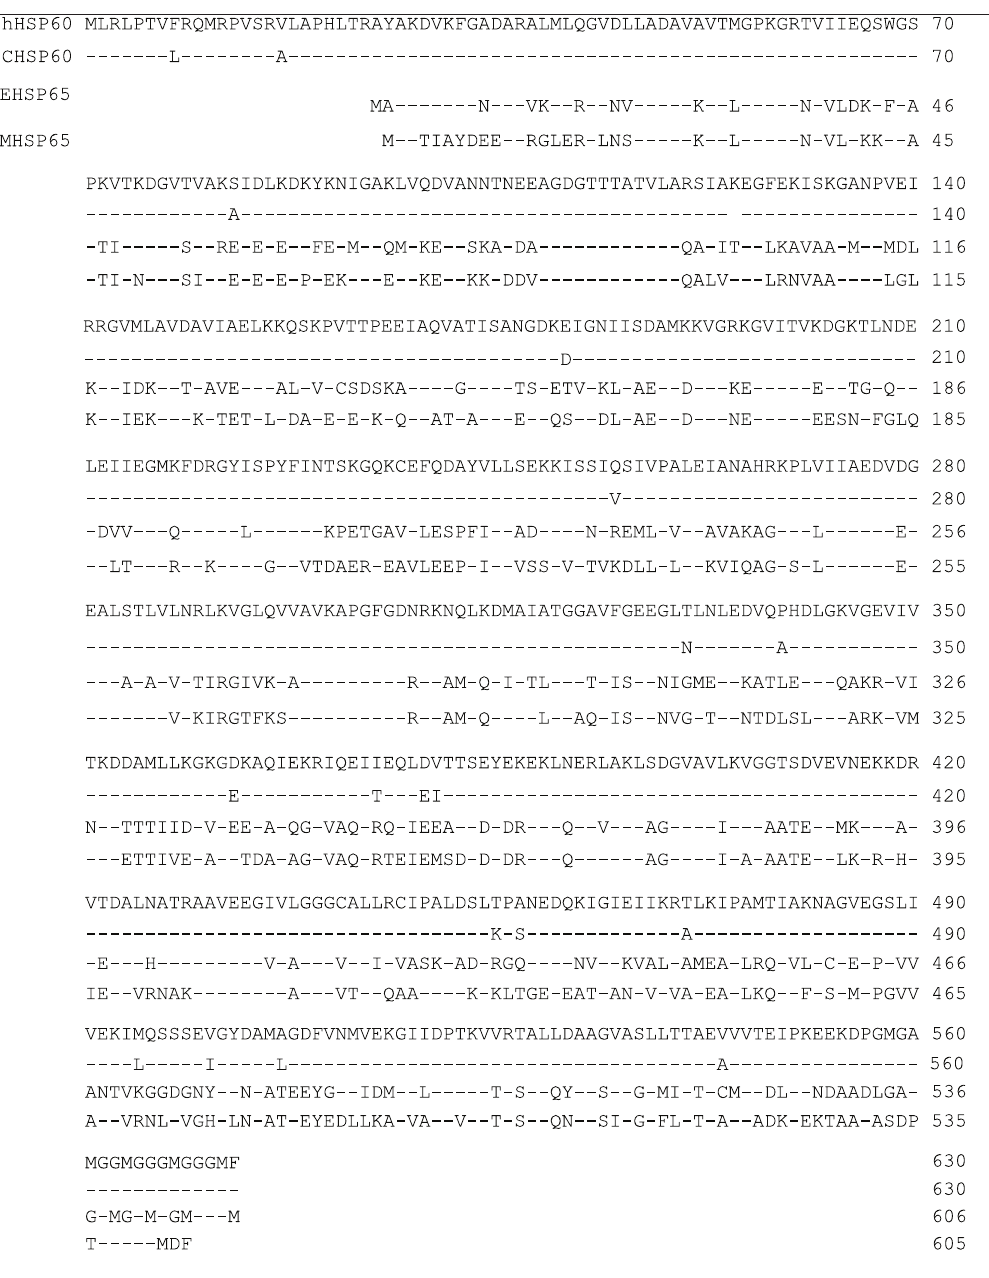
Table 1: Comparison of the amino acid sequences of human, Chinese hamster (C) HSP60, Escherichia coli (E), and Mycobacterium leprae (M) HSP65